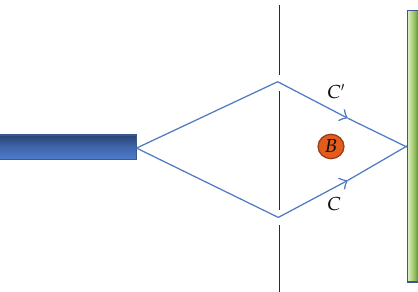
Figure 1: The canonical Aharonov-Bohm setup, with electrically charged particles moving along each of two paths, C and C (cid:2) , before interfering on a